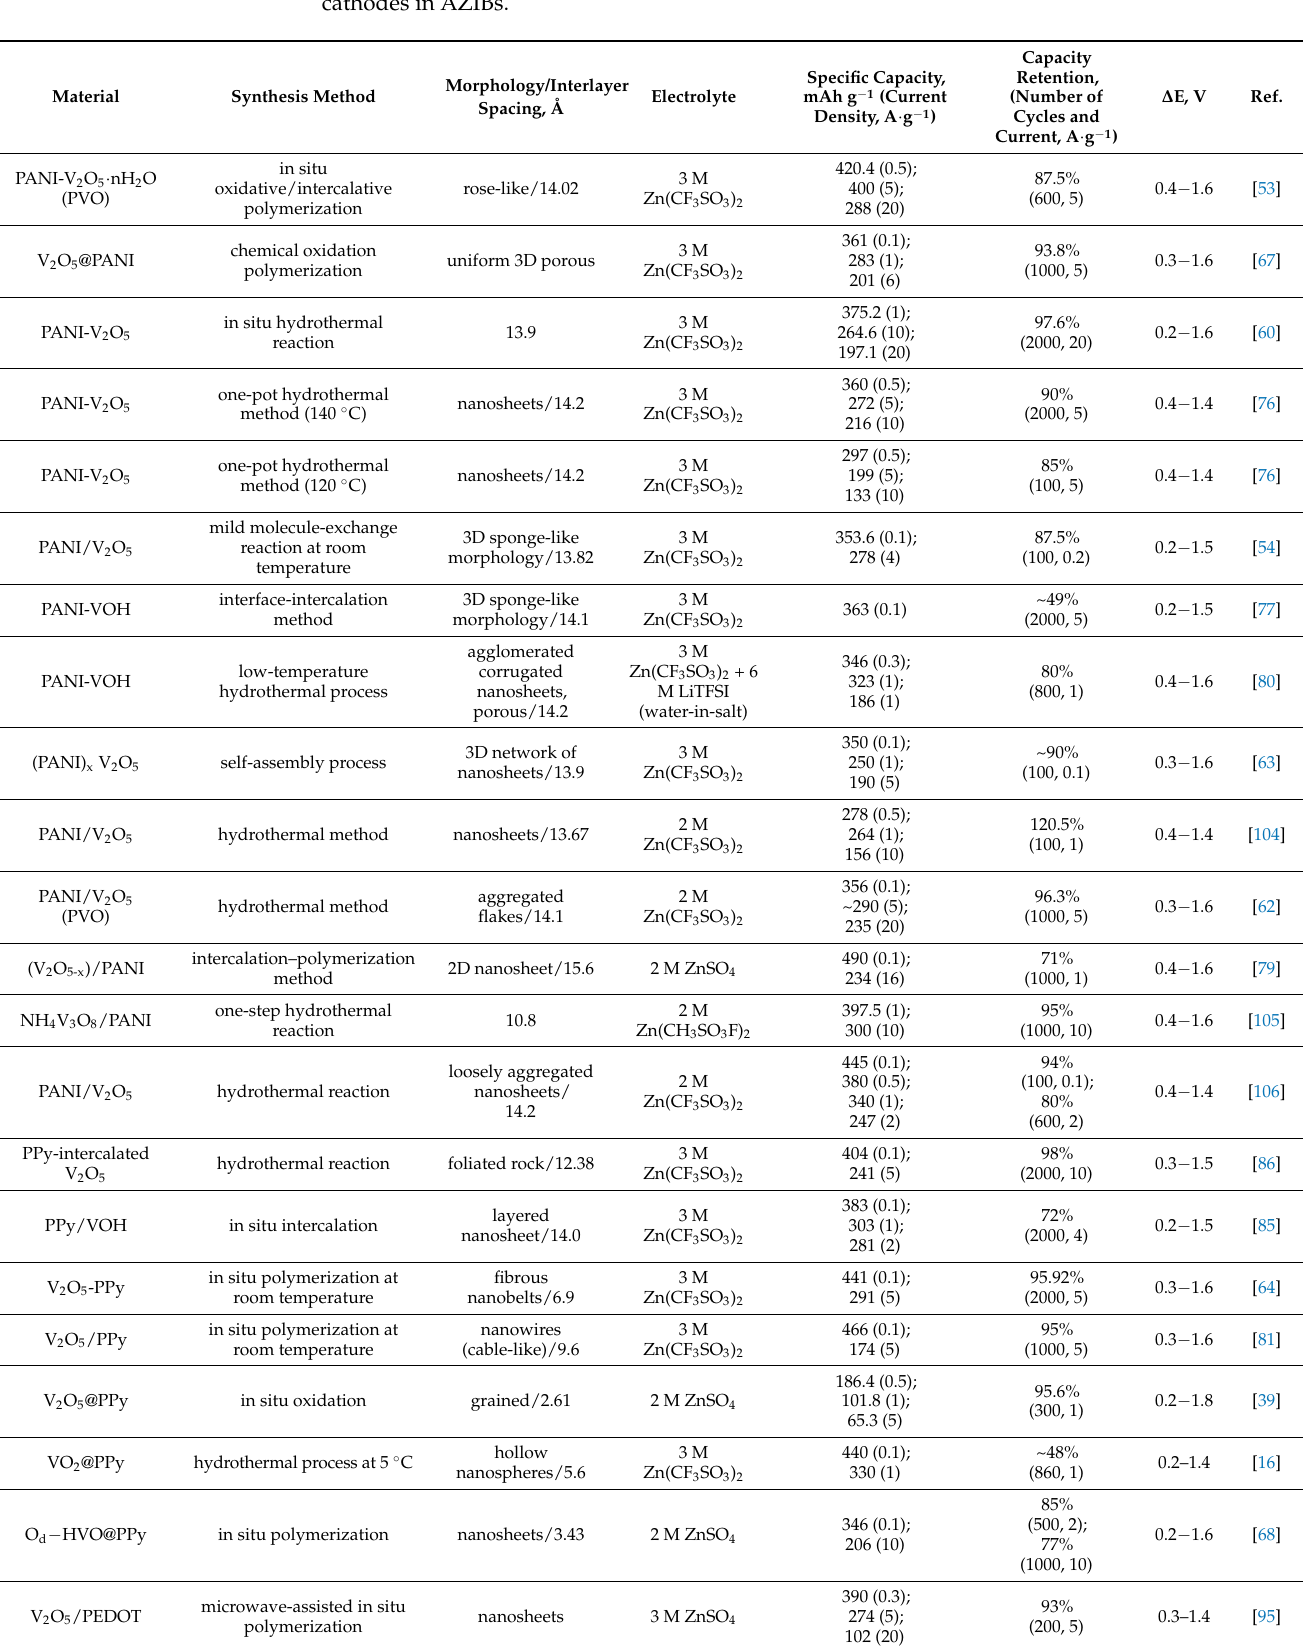
Table 1. Electrochemical performance of selected vanadium oxide-based composites with CPs as cathodes in